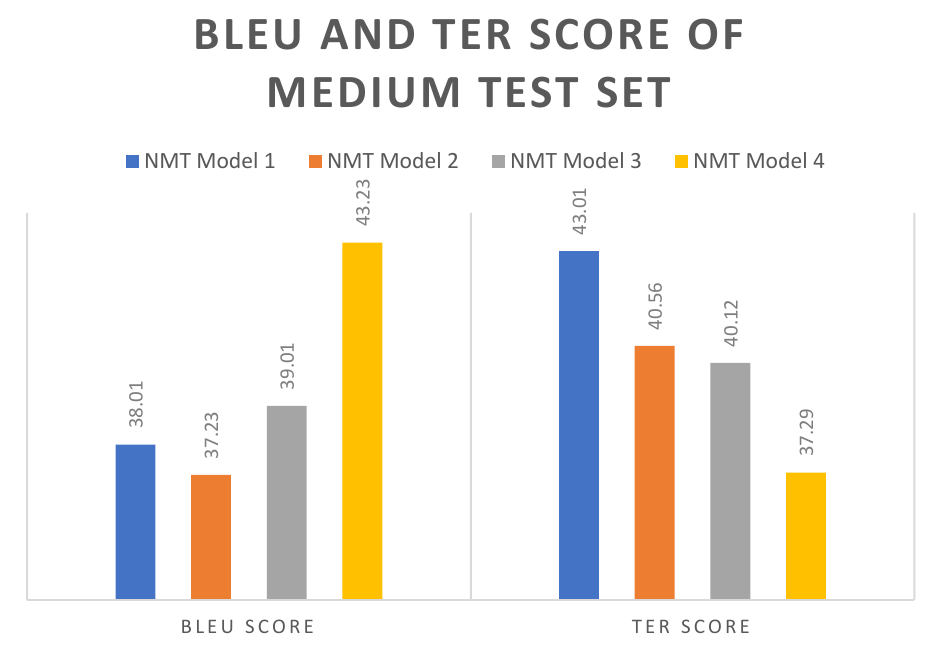
Figure 7. BLEU and TER scores of the medium test set.